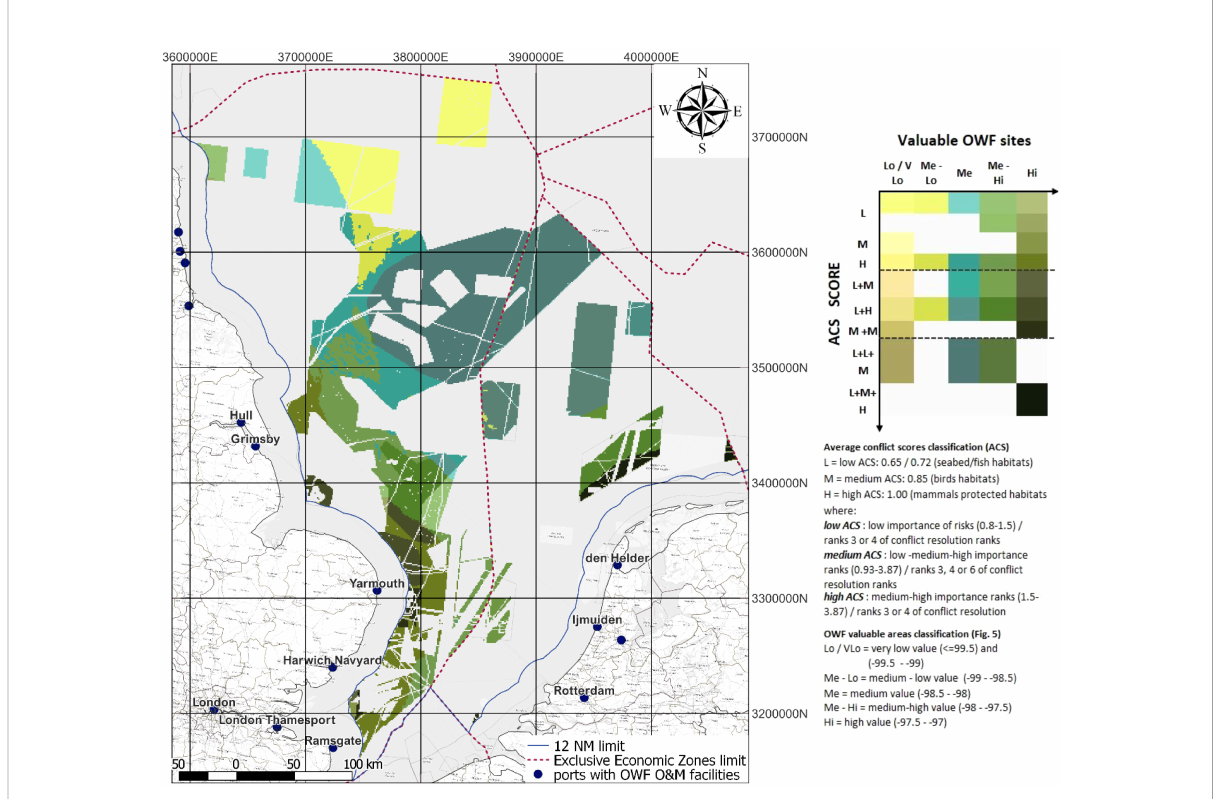
FIGURE 7 Spatial distribution (cumulated area of con fl ict) of con fl icts (ACS) within the OWF valuable sites, for fi sheries sea user group